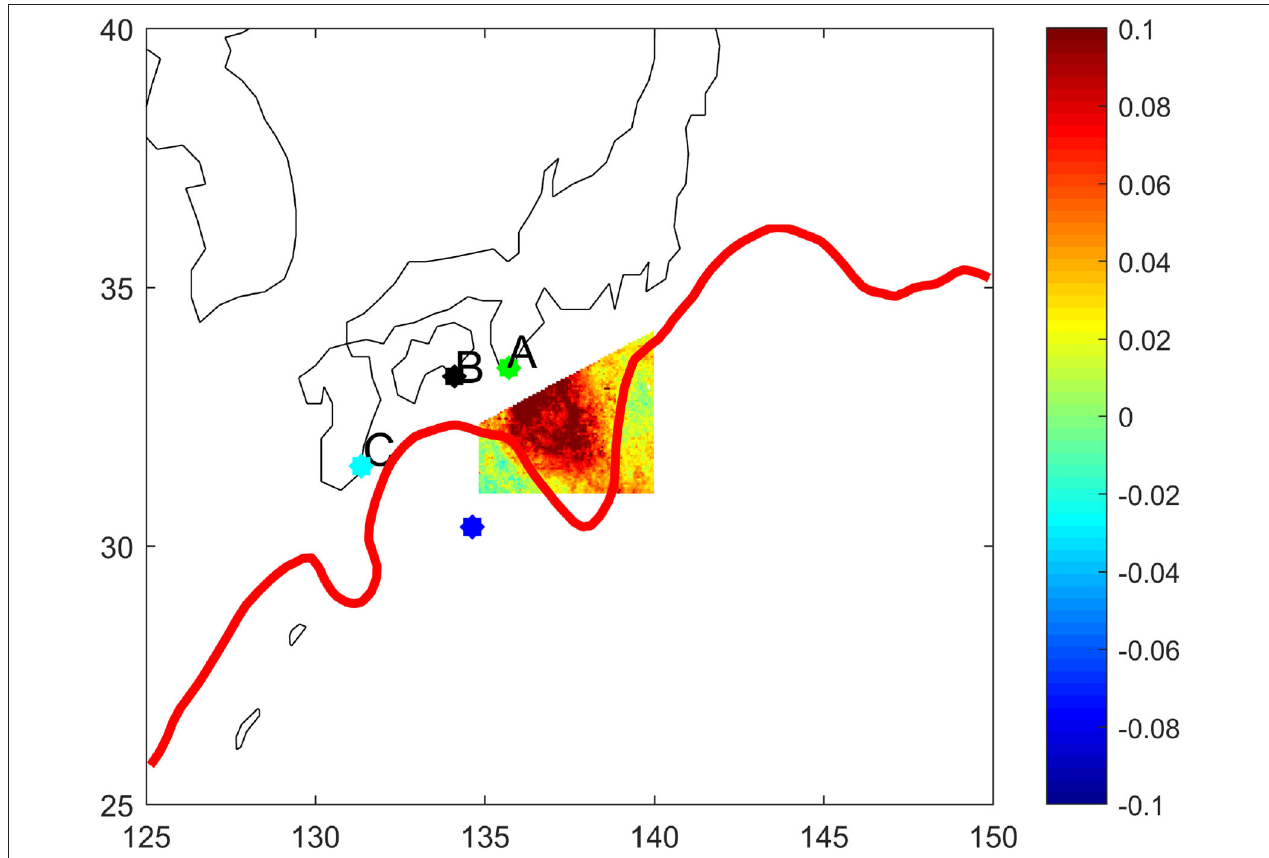
FIGURE 8 | Selected area for representing the LM chlorophyll-a anomaly in color shading and three coastal stations in Cape Shiono-Misaki (A), Shikoku (B), and south of Kyushu (C). Red contour indicates the Kuroshio axis defined with the SSH value at 1.2 m. Blue dot shows an example of the SSH maximum within the recirculation